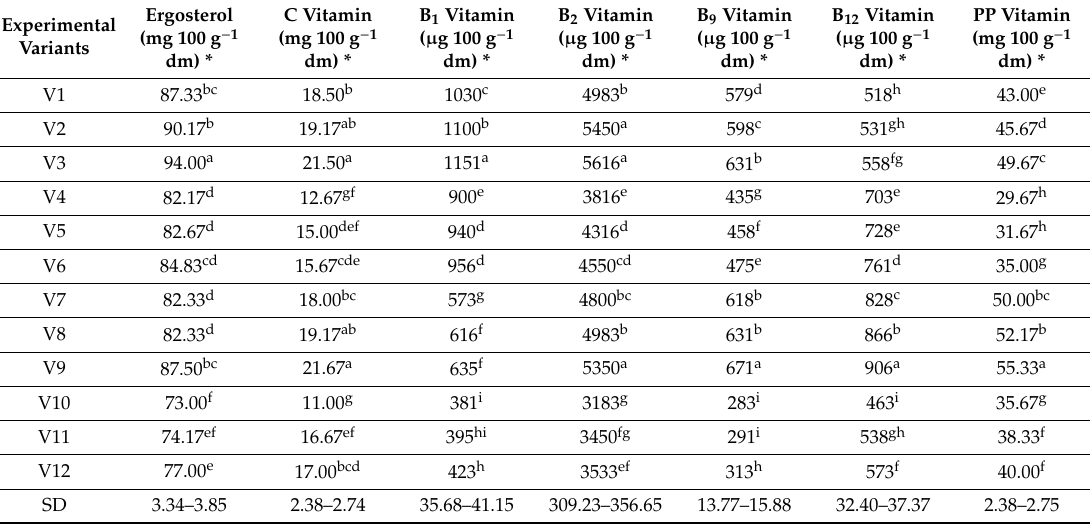
Table 1. Vitamin content of Agaricus blazei Murrill mushrooms.